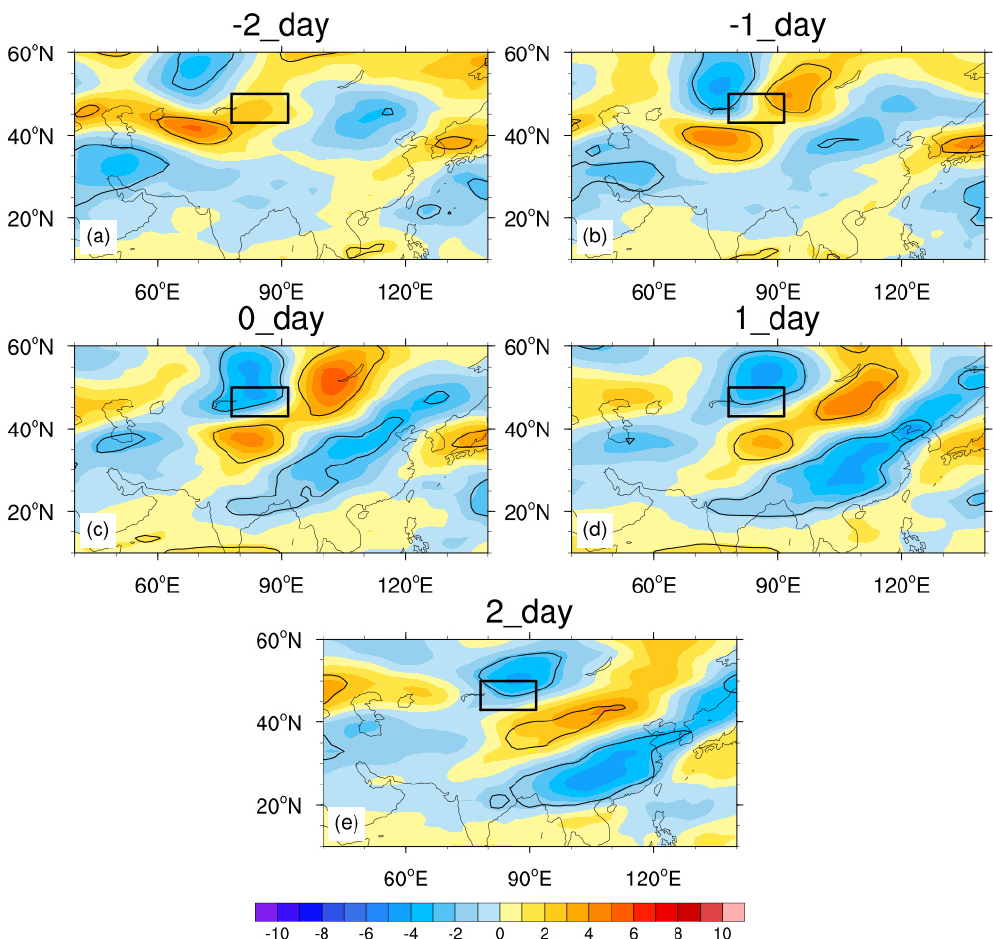
Figure 10. Composition of U200 anomaly of Type EN on the extreme precipitation day and the two days before and after ( a – e ) in the summers of 1979–2018 (Unit: m/s). The black box represents the location of the Northern Xinjiang region, and the region over the 95% significant confidence level is circled with black lines.